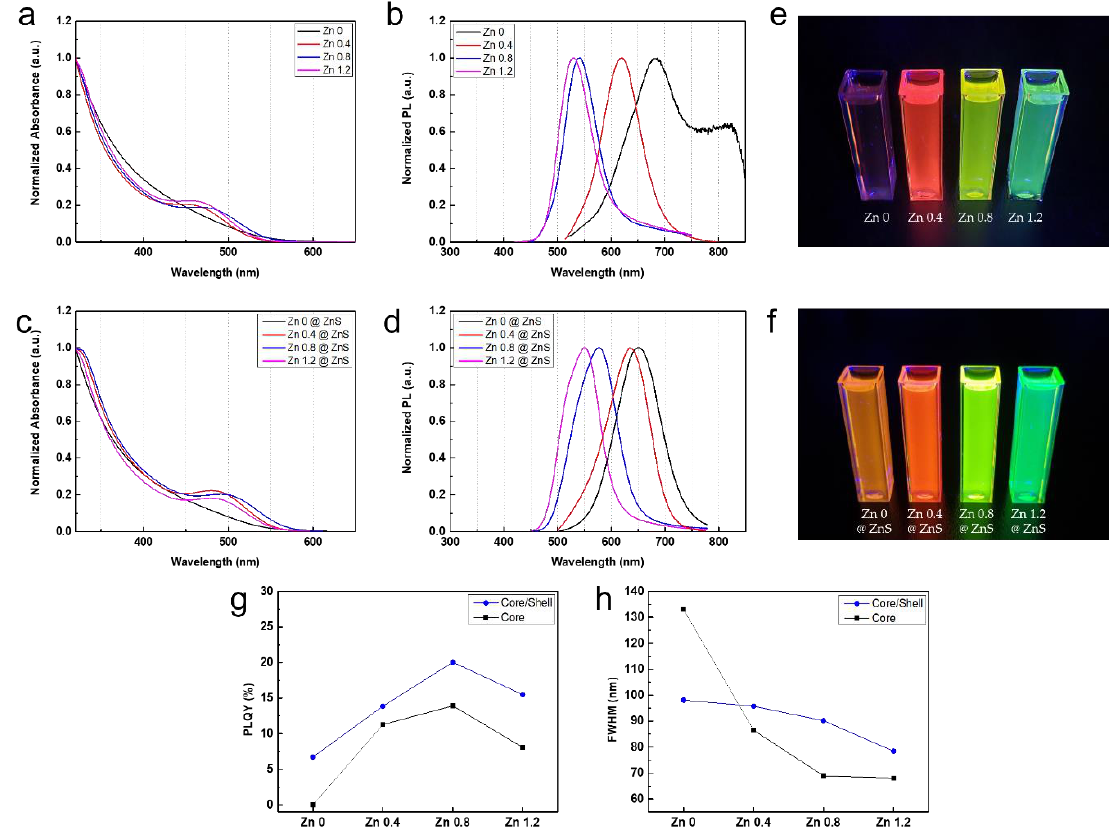
Figure 1. ( a – d ) absorption spectroscopy and PL measurement of In(Zn)P core ( a , b ) and In(Zn)P @ ZnS CQDs ( c , d ). Samples under UV illumination of In(Zn)P core (left to right, Zn 0, Zn 0.4, Zn 0.8, Zn1.2) ( e ) and In(Zn)P @ ZnS CQDs (left to right, Zn 0 @ ZnS, Zn 0.4 @ ZnS, Zn 0.8 @ ZnS, Zn 1.2 @ ZnS) ( f ). ( g , h ) PLQY ( g ) and FWHM ( h ) of CQDs depending on Zn loading amounts in the synthesis.